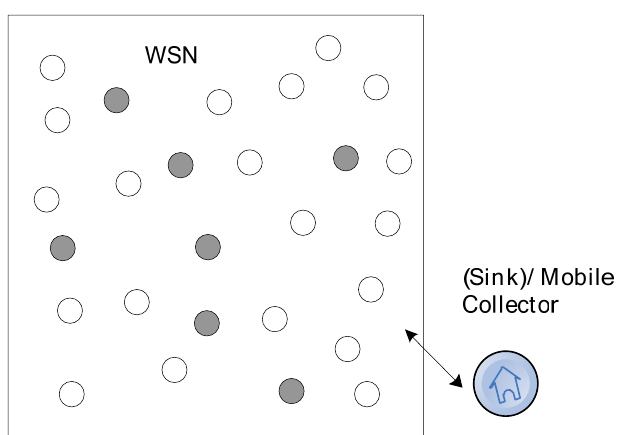
Figure 2. The network